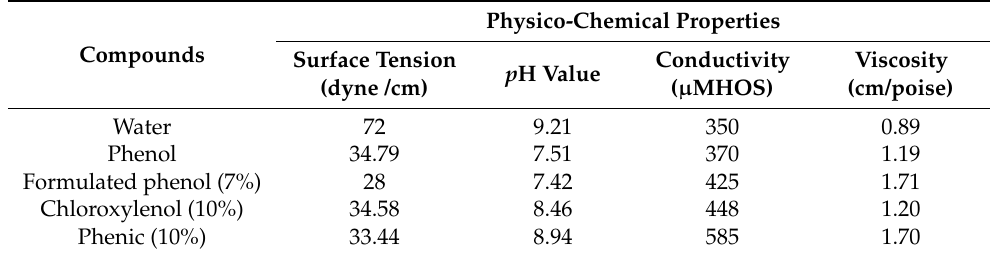
Table 4. Physicochemical properties of spray solution at the recommended field dilution rate (1.5%).